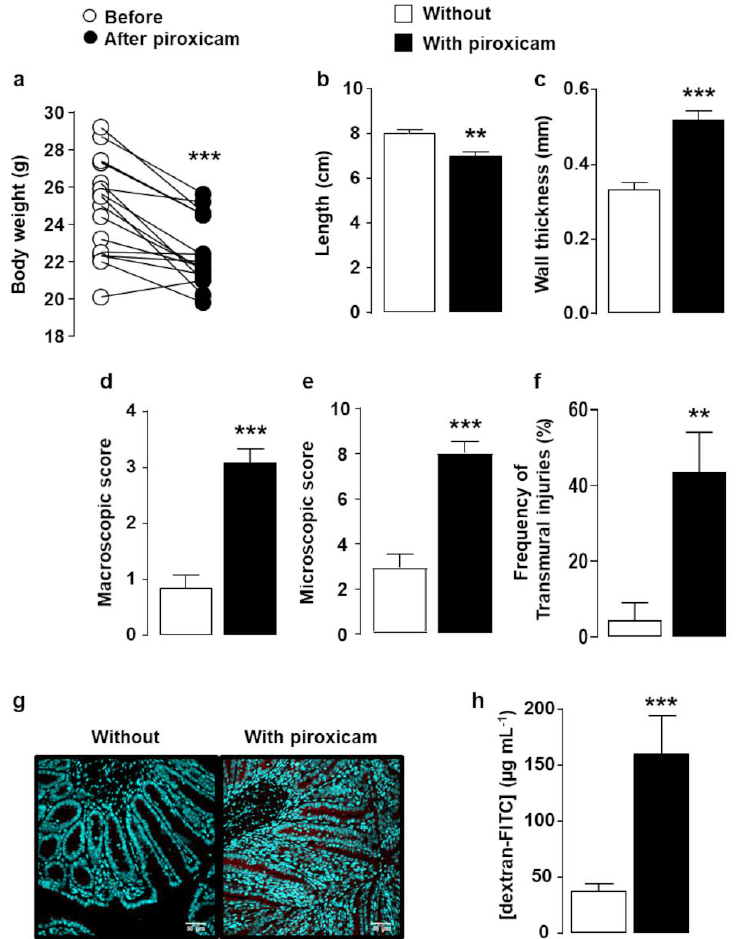
Figure 1. Colitis severity in IL-10 -/- mice fed with piroxicam. IL-10 -/- mice were fed with standard chow diet without (white) or with piroxicam (black) for 10 days ( n = 14–18/group). Colitis parameters included body weight loss (( a ), bodyweight before (white circle) and after piroxicam treatment (black circle), each symbol represents 1 mouse), colonic length ( b ), wall thickness ( c ), both macroscopic ( d ), and microscopic ( e ) colonic tissue damage including the percentage of transmural colon injuries ( f ). A representative immunohistological staining of apoptotic epithelial cells using anti-activated caspase 3 antibodies is shown in ( g ). Paracellular permeability expressed as the mean of FITC-dextran concentration in serum ( µ g mL − 1 ) 4 h after gavage with dextran is depicted in ( h ). Data are expressed as mean ± SEM. Statistical analyses were performed using the Mann–Whitney U test except for panel A where statistical analysis was performed using the Wilcoxon matched pairs test, ** p < 0.01, *** p <